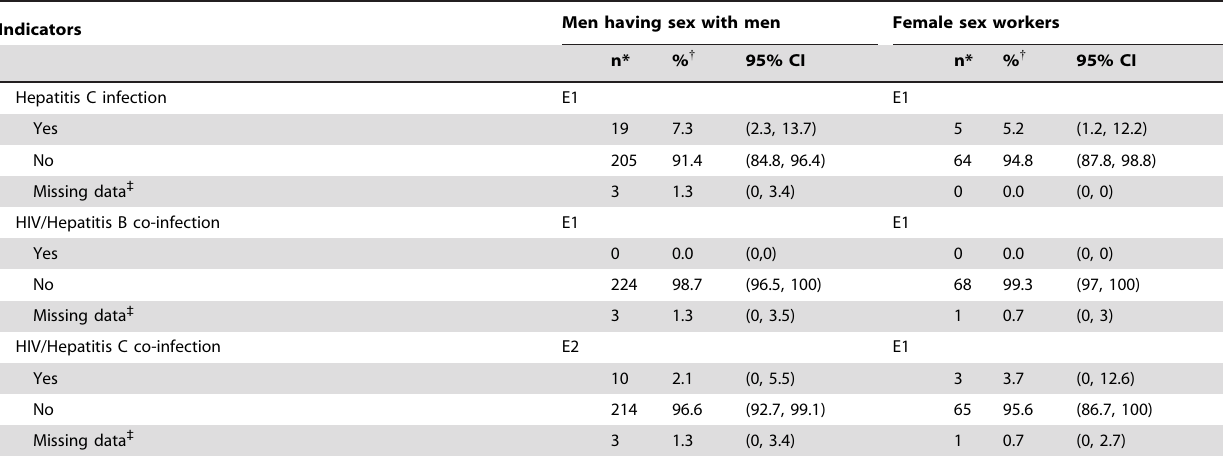
Indicators Men having sex with